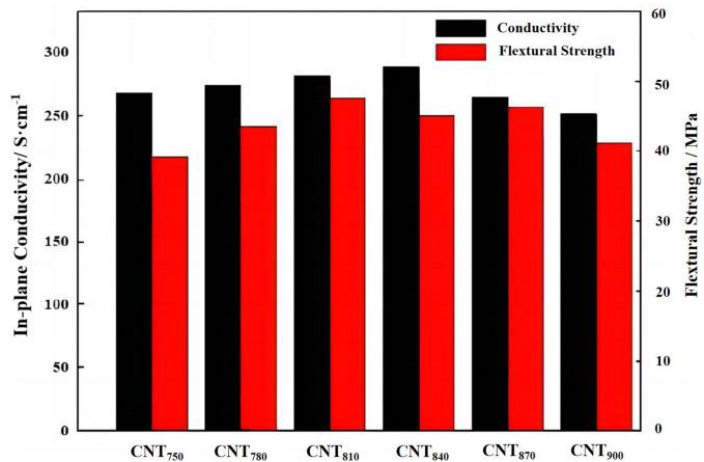
Figure 5. Electrical conductivity and flexural strength of composite BPs prepared from MWCNTs at different temperatures.